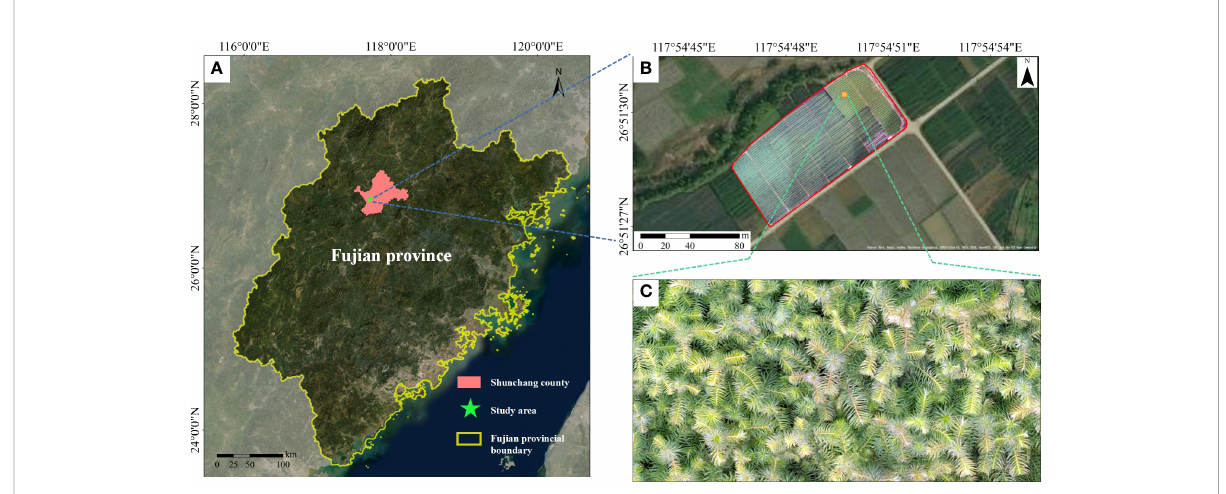
FIGURE 1 Study area. (A) Geographical location of the study area, (B) Overview of study Area, (C) Local details of the study